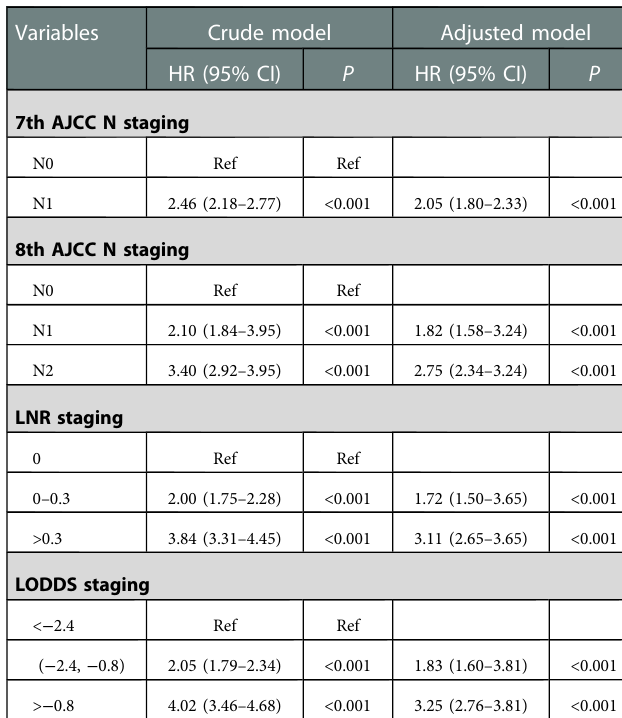
Figure 2 shows the ROCs of four staging systems (the 7th edition AJCC N staging system, the 8th edition AJCC N staging system, LNR staging and LODDS staging) predicting OS at 6, 12, 24 and 48 months in training and testing sets. In the testing set, LODDS staging predicting OS was superior to other staging systems at 6 months [area under the curve (AUC) = 0.687], 12 months (AUC = 0.692), and 48 months (AUC = 0.709) in AC patients ( Figure 2B,D and H). LNR staging (AUC = 0.655) and LODDS staging (AUC = 0.654) were both potential predictor of OS at 24 months in AC patients ( Figure 2F ).